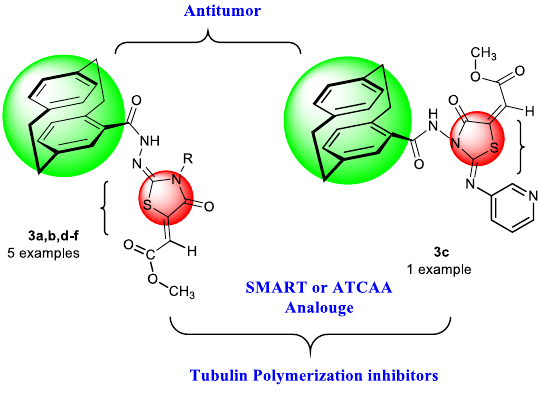
Figure 2. Structures of biologically active thiazole and paracyclophane derivatives.